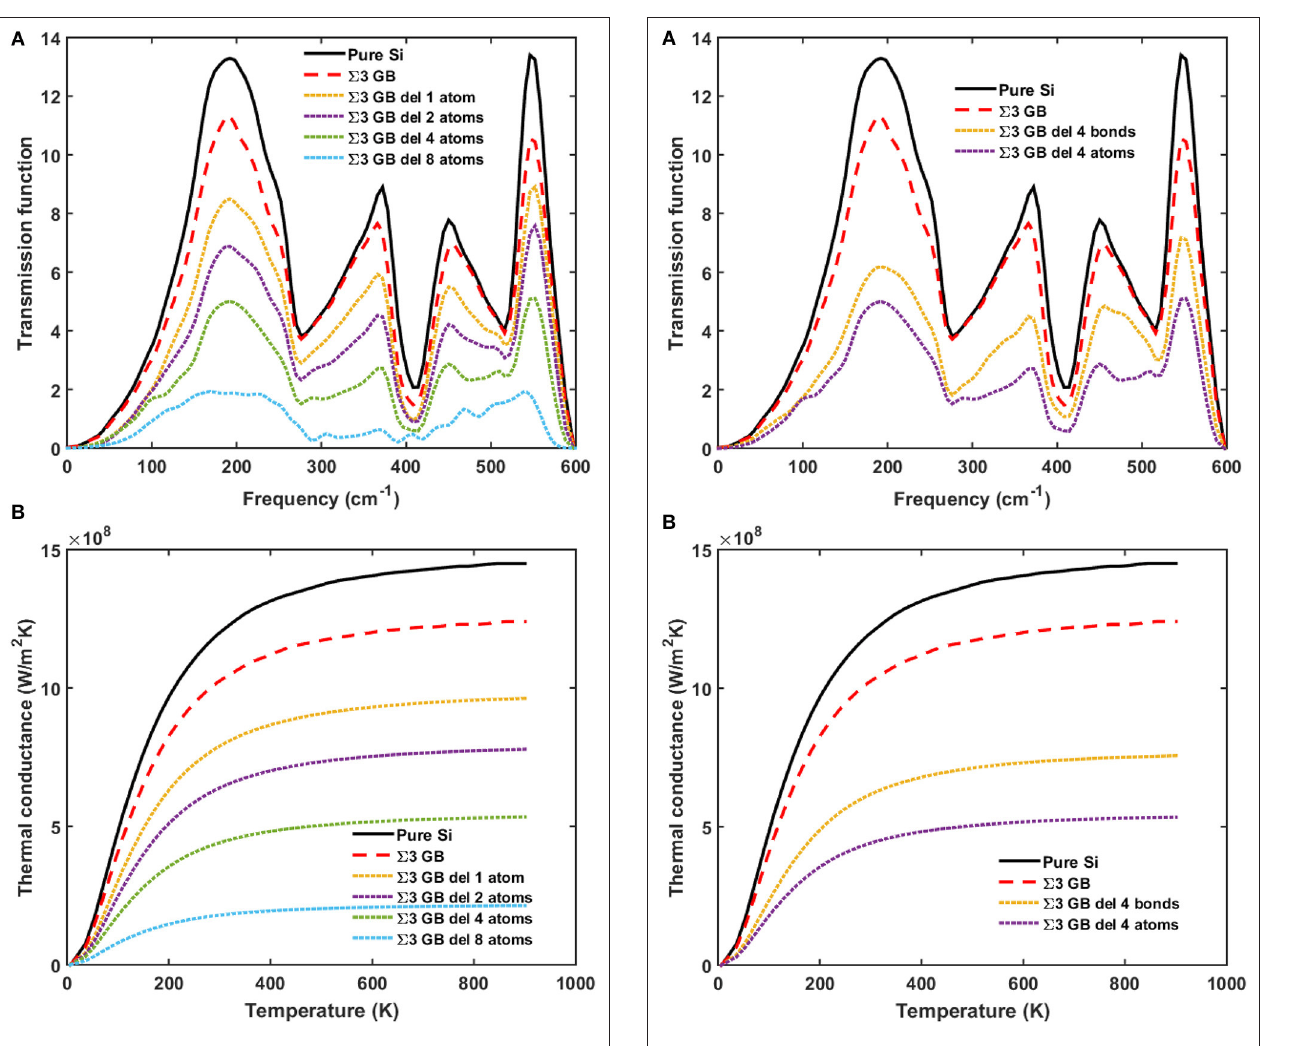
FIGURE 4 | (A) Phonon transmission and (B) thermal conductance for pure silicon (black solid line), silicon with perfect 6 3 grain boundary (red dashed line), and silicon with defective 6 3 grain boundary with missing atoms (dotted lines).